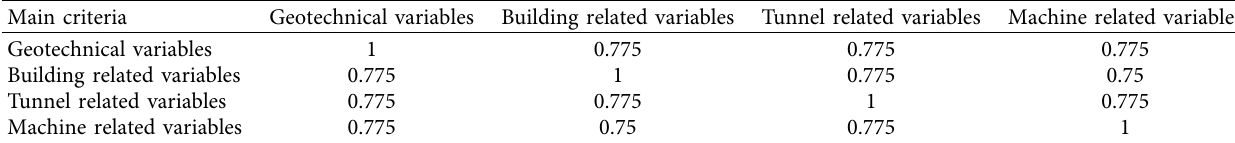
Table 7: Te determinacy value of the main criteria.